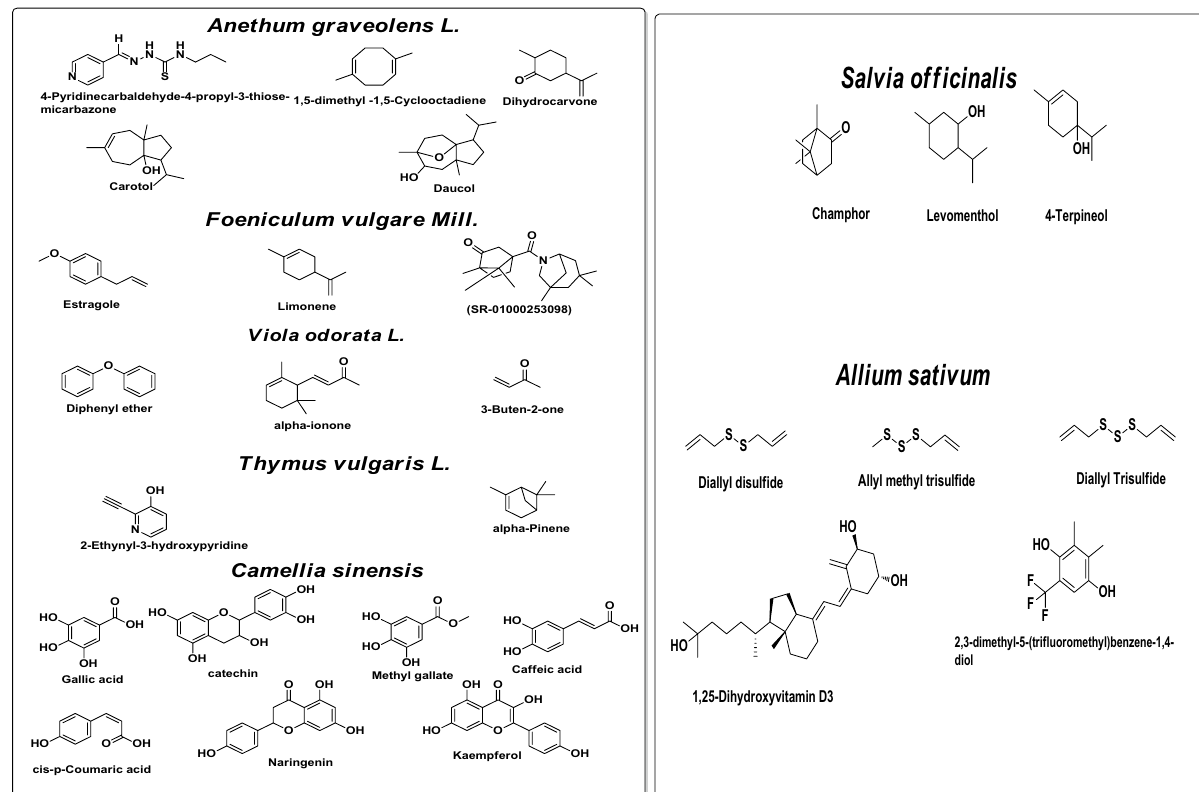
Figure 7. Essential oils and their most active